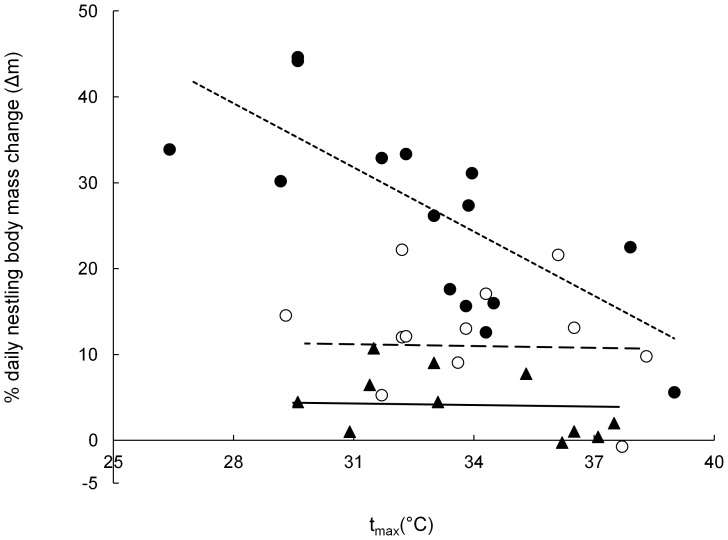
The effect of maximum daily temperature on % daily mass change of nestlings.The negative effect of tmax on % daily mass change of nestlings (Δm) was modified by nestling age. Closed circles and dotted line represent six-day old nestlings; open circles and dashed line represent ten-day old nestlings, stars and solid line represent 14-day old nestlings. Each data point represents Δm averaged over all nestlings in a single brood. Lines of best fit were calculated using model predictions from a GLMM at average levels of provisioning and take into account variance caused by random terms.